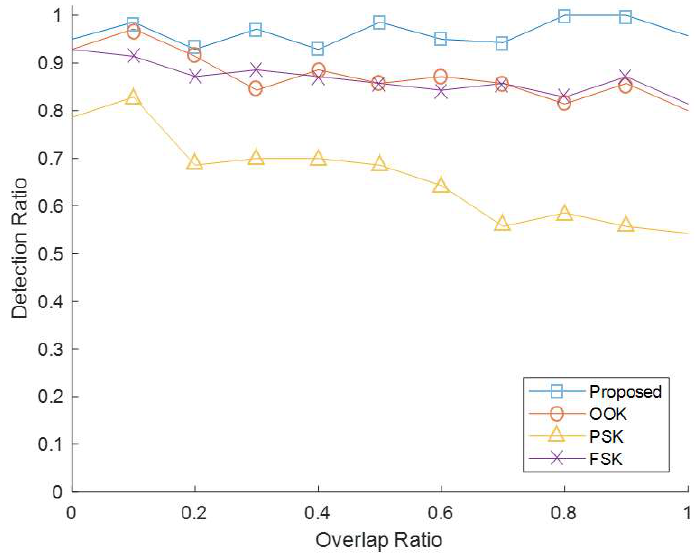
Figure 10. Comparison of detection ratio according to overlap of the proposed method and the ex- isting